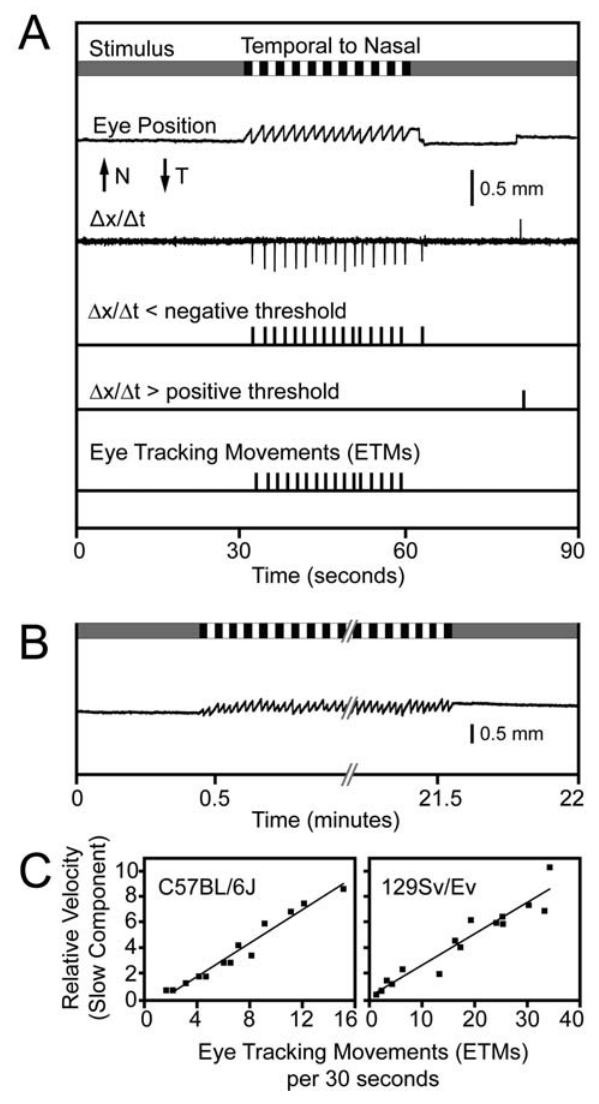
Figure 2. Stimulus, response, and data analysis during an OKR recording session with a wildtype mouse. (A) From top to bottom, the following features are shown. The schematic of the visual stimulus over a 90 second period represents: (1) a uniform grey during the first and last 30 second of the recording period, and (2) a pattern of black and white vertical stripes (each stripe subtending 4 u ) rotating at 5 u per second in a temporal to nasal direction (with respect to the eye that is imaged) during the middle 30 seconds of the recording period. ‘‘Eye Position’’ indicates the horizontal difference between the center of the pupil and the center of the corneal reflection which shows a slow and uniform temporal-to-nasal motion interrupted approximately every two seconds by a rapid nasal-to-temporal saccade. N, nasal; T, temporal. The first derivative of eye position is shown above a pair of traces that indicate the times at which the first derivative exhibits an excursion below or above negative or positive thresholds, respectively. At the bottom are the assignments of discrete eye-tracking movements (ETMs) during the 30 second stimulus interval scored by inspection of eye position and its first derivative; the rightmost suprathreshold negative excursion on the first derivative plot is not counted as an ETM because it occurred outside of the 30 second stimulus interval. An identical ETM assignment was made by NeuralWorks Predict Version 3.13, a neural network (NeuralWare, Carnegie PA). (B) OKR over a continuous 21 minute period of rotating vertical black and white stripes shows essentially no adaptation. (C) ETMs per 30 second interval vs. the relative velocity of the slow component for C57BL/6J and